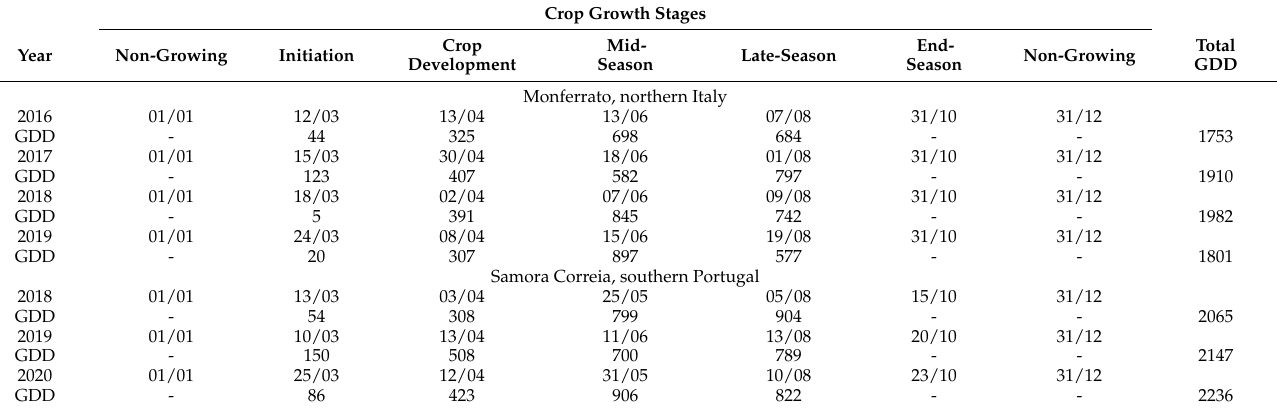
Table 2. Crop growth stage dates of vines in the various case studies and duration of growing seasons (in